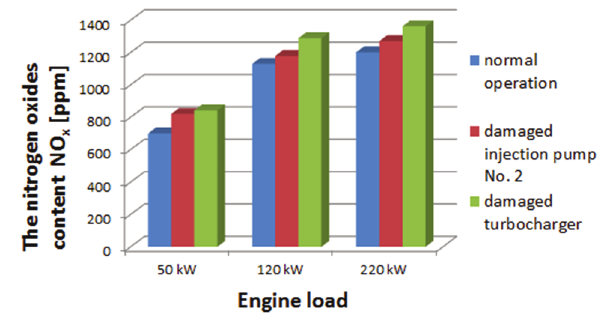
Fig. 7. The influence of engine load on the content of nitrogen oxides NO x [ppm] indicated by the analyzer for various engine